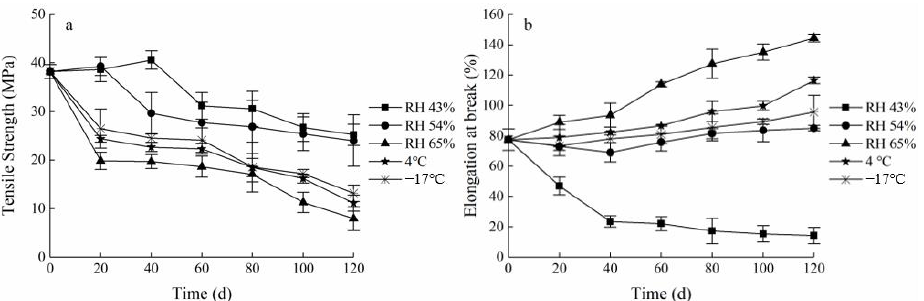
Figure 5. Changes in mechanical properties of Maillard-modified FG-Ara composite films during storage. ( a ) Tensile strength (TS); ( b ) elongation at break (EAB). storage. ( a ) Tensile strength (TS); ( b ) elongation at break